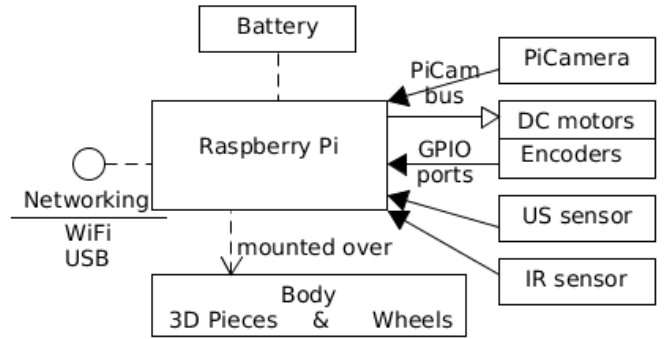
Figure 4. Hardware design of the PiBot robot.